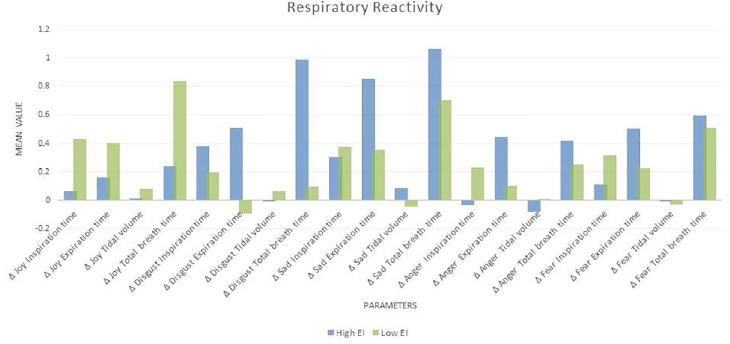
Fig 7. Mean respiratory reactivity of high and low EI